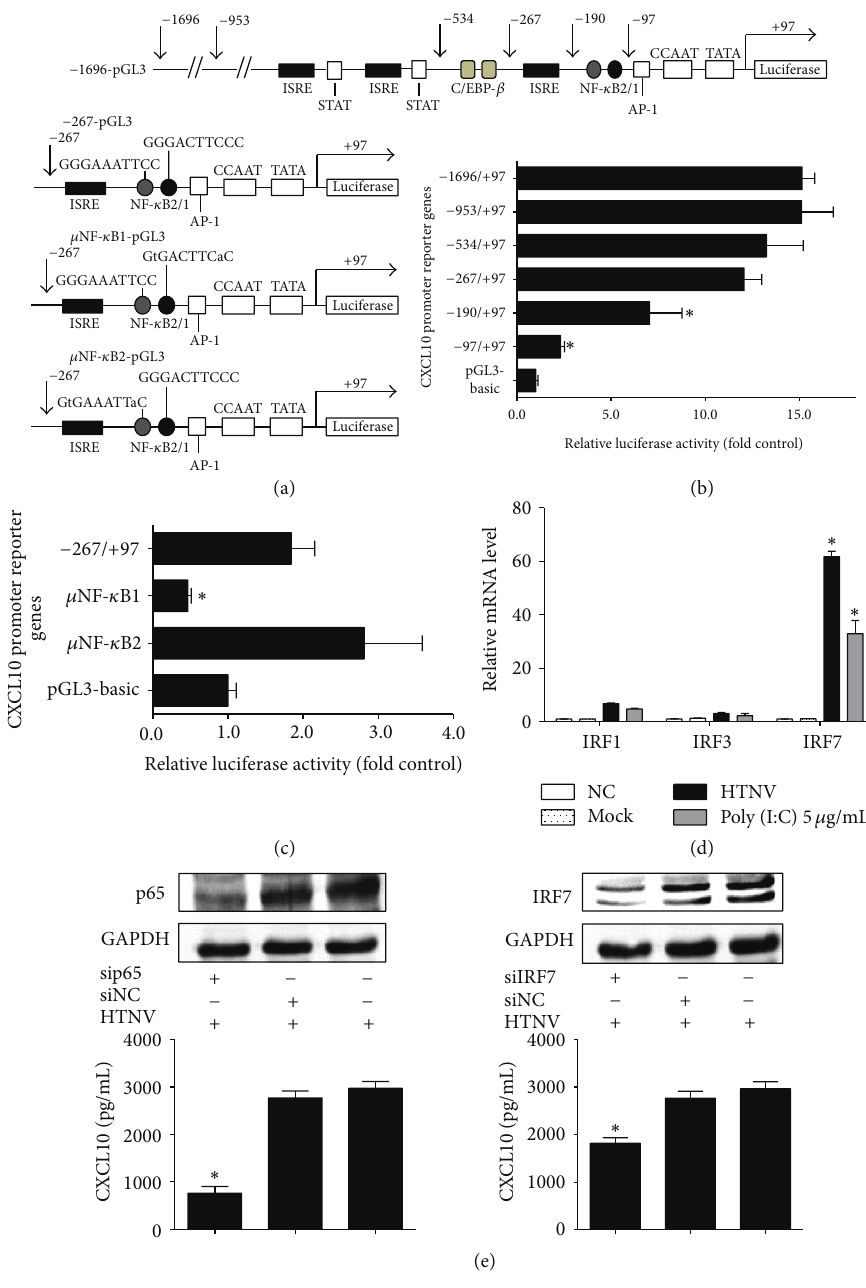
Figure 4: NF- 𝜅 B1 and IRF7 upregulate CXCL10 expression. (a) Schematic diagram of full-length, truncated, and mutated CXCL10